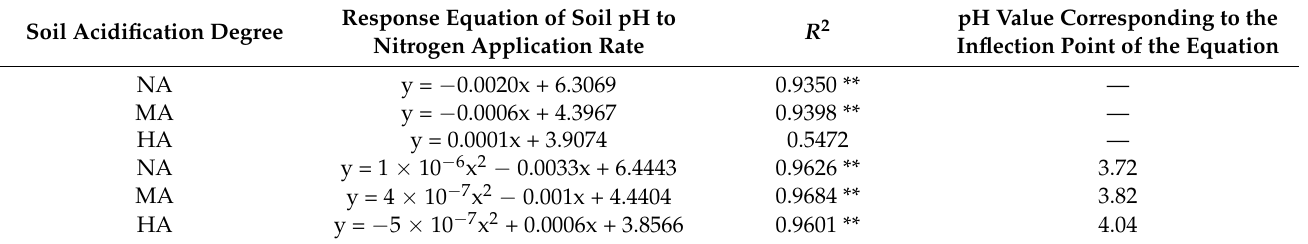
Figure 1. Effect of N application rate on soil pH at tea plantations with different degrees of acidification. Note: the different lowercase letters indicate significant differences at p < 0.05 for different N application rates at the same degree of acidification. Table 2. Response equations of soil pH to N application rate at tea plantations with different degrees of acidification.